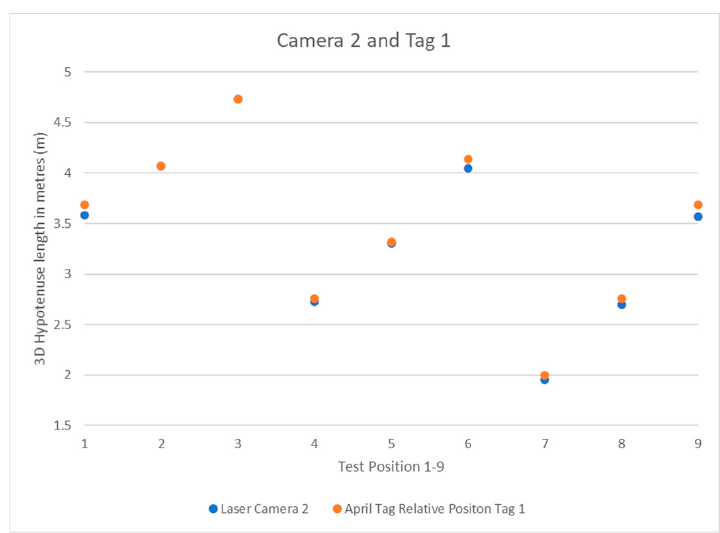
Figure 12. Camera 2 and Tag 1 Position Results.